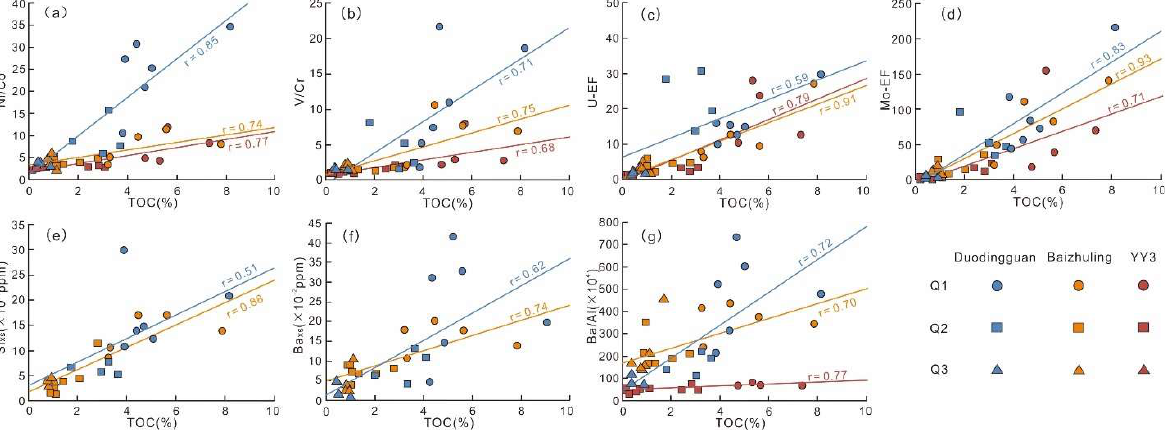
Figure 7. ( a – d ) The relationships between the redox indicators (Ni/Co, V/Cr, U-EF, and Mo-EF) and the TOC content; and ( e – g ) the relationships between the paleo-productivity indicators (Si xs ×10 −4 , Ba xs ×10 −2 , and Ba/Al×10 4 ) and the TOC content.